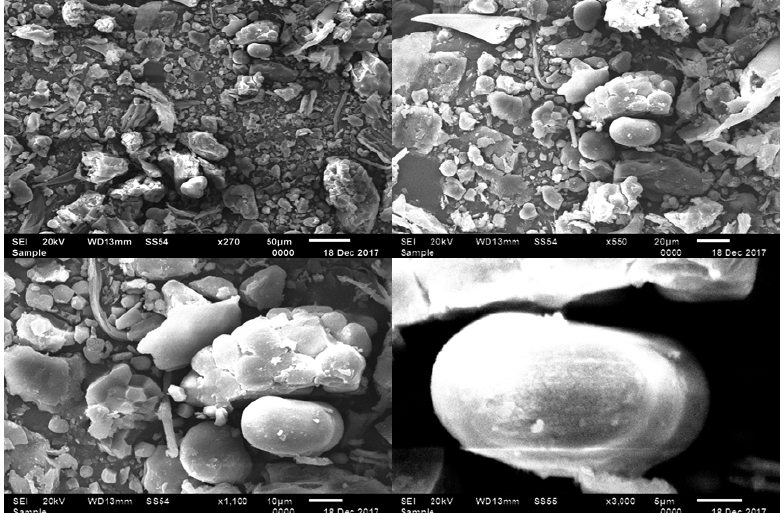
Figure 1. Scanning Electron Micrograph (SEM) of mixed adsorbent before